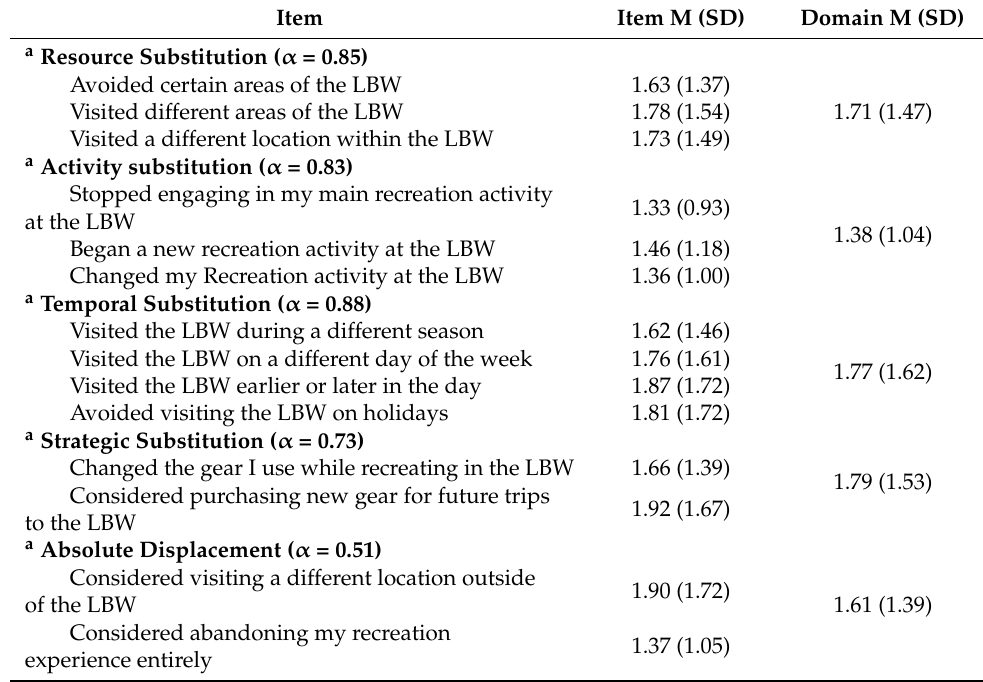
Table 2. LBW Visitors’ Employment of Coping Mechanisms and Intention-to-return to the LBW. Item Item M (SD)